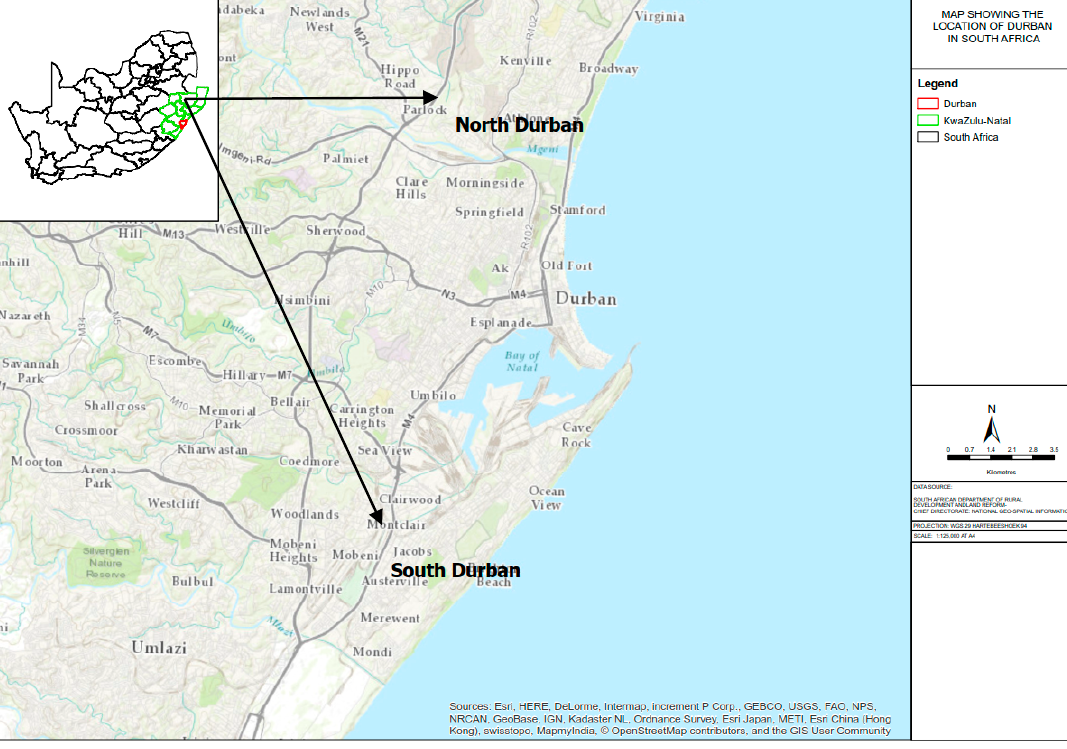
Figure 1. Location of Durban north and Durban south, and their location within South Africa (inset map).